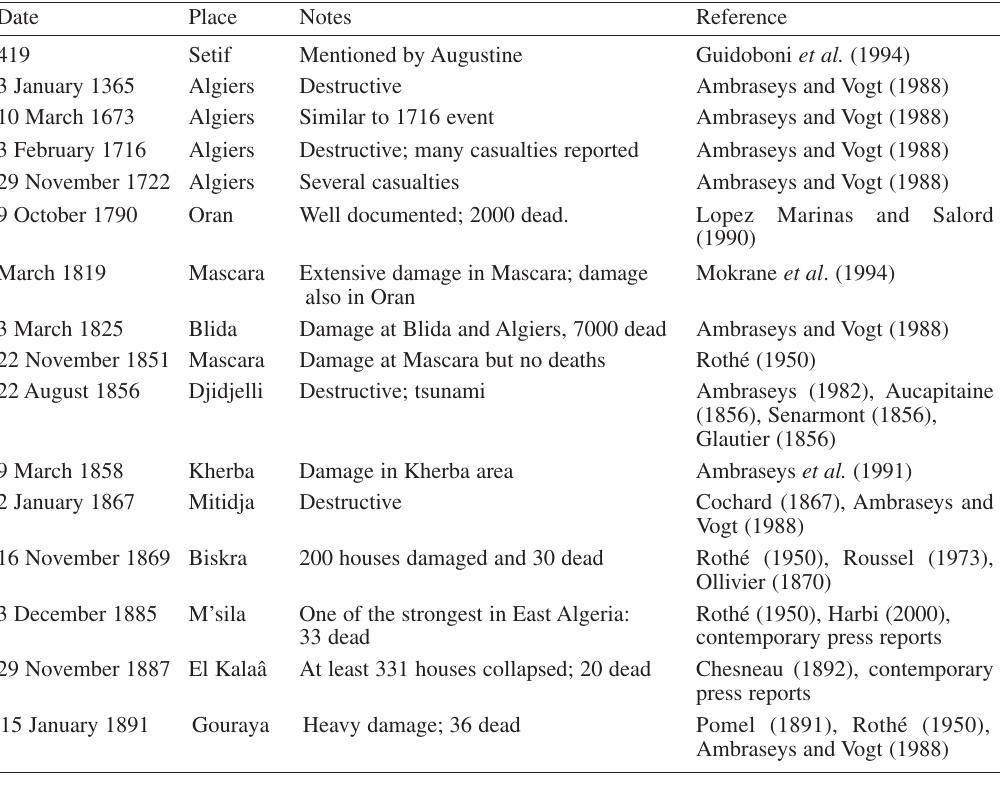
Table I. Selected historical earthquakes of note in Algeria (see fig. 1 for location of places).